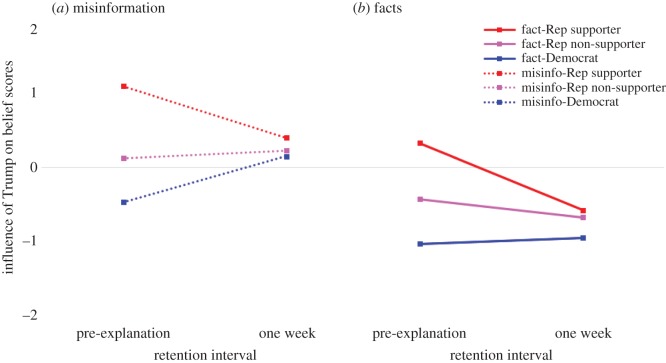
(a,b) Influence of Trump—Trump-attributed scores subtracted from unattributed scores— across Trump support. Misinfo, misinformation; Rep, Republican. Dotted lines show misinformation items.